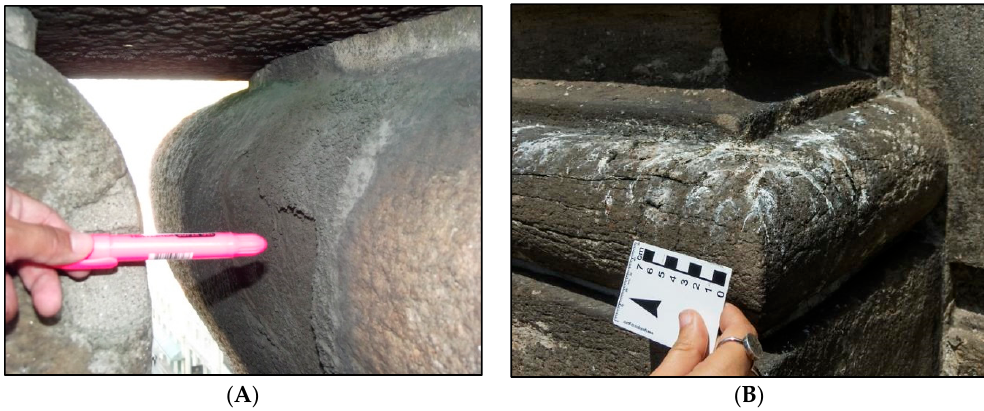
Figure 5. ( A ): Black crust in gneiss; ( B ): Efflorescence in gneiss.